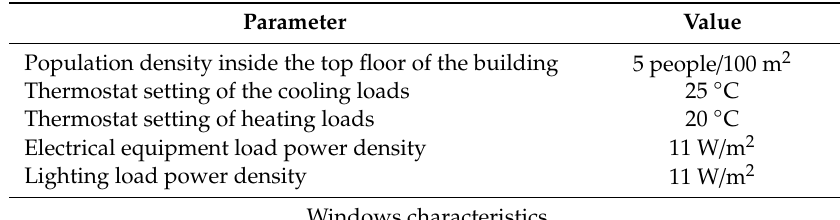
Table 4. Parameters of